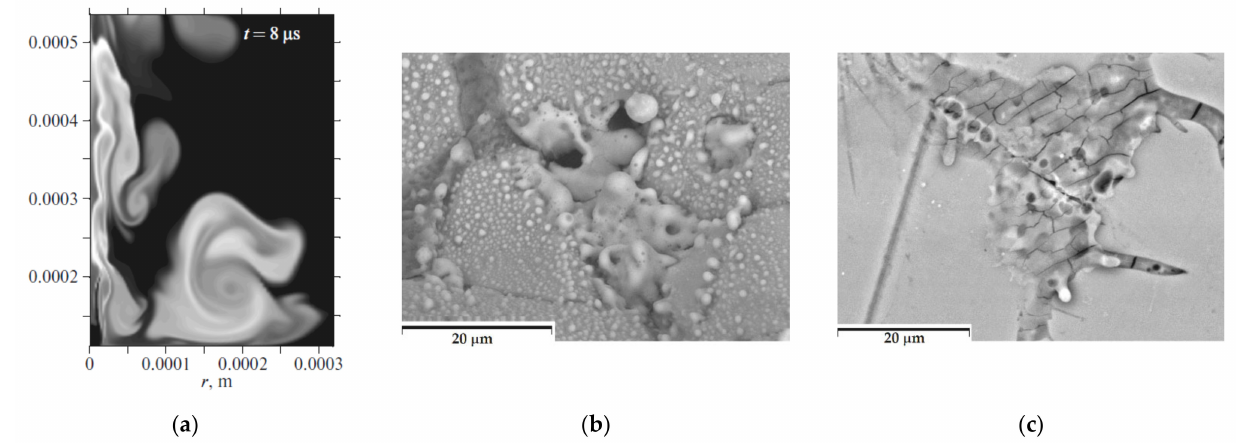
Figure 5. ( a ) Distribution of condensed matter at the late stage of iron vapor outflow from the nanosecond breakdown channel of sulfide minerals (pyrite); presented in the paper [117]. ( b , c ) New formations of the iron oxides (hydroxides) on the surface of ( b ) pyrite and ( c ) arsenopyrite after treatment by HPEMP ( t treat = 10–30 s). SEM − EDX; scale bars: ( b , c ) 20 µ